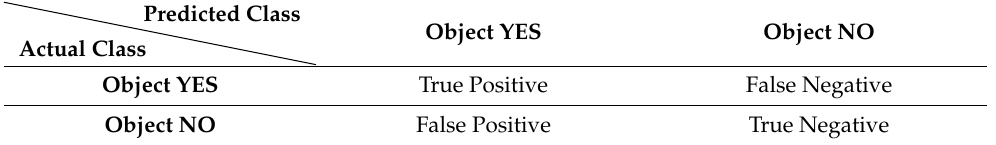
Table 3. Classification of recognition